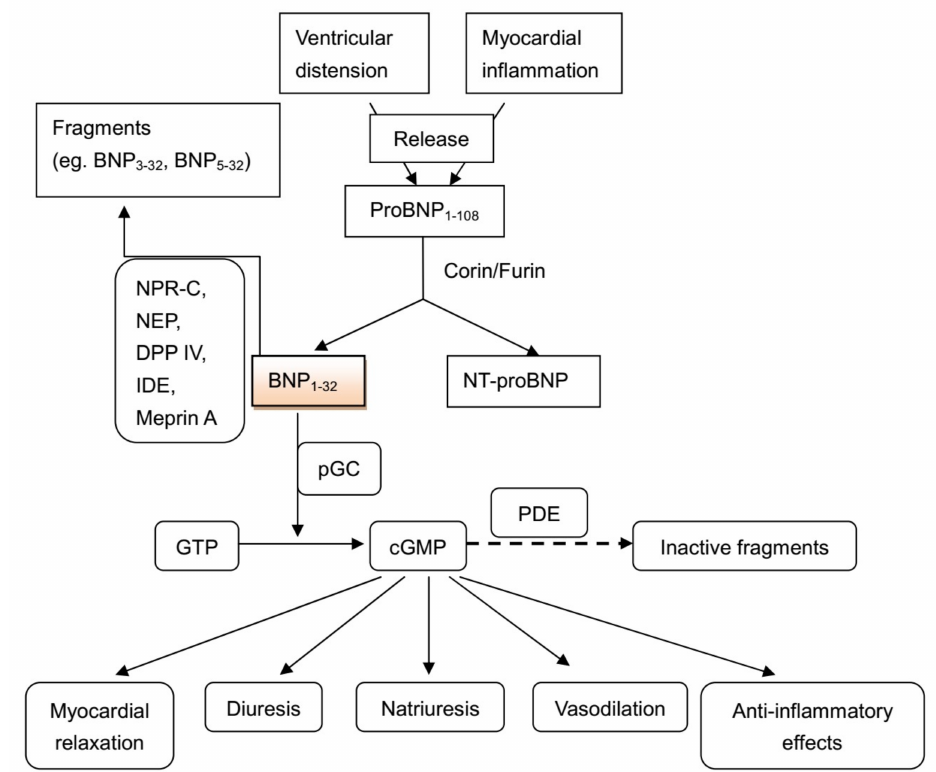
Figure 2. Cascade of BNP release and consequent physiological effects and clearance. BNP = B-type natriuretic peptide; NPR-C = natriuretic peptide receptor C; NEP = neutral endopeptidase; DPP IV = dipeptidyl peptidase IV; IDE = insulin degrading enzyme; pGC = particulate guanylate cyclase; PDE = phosphodiesterase; GTP = guanosine triphosphate; cGMP = cyclic guanosine